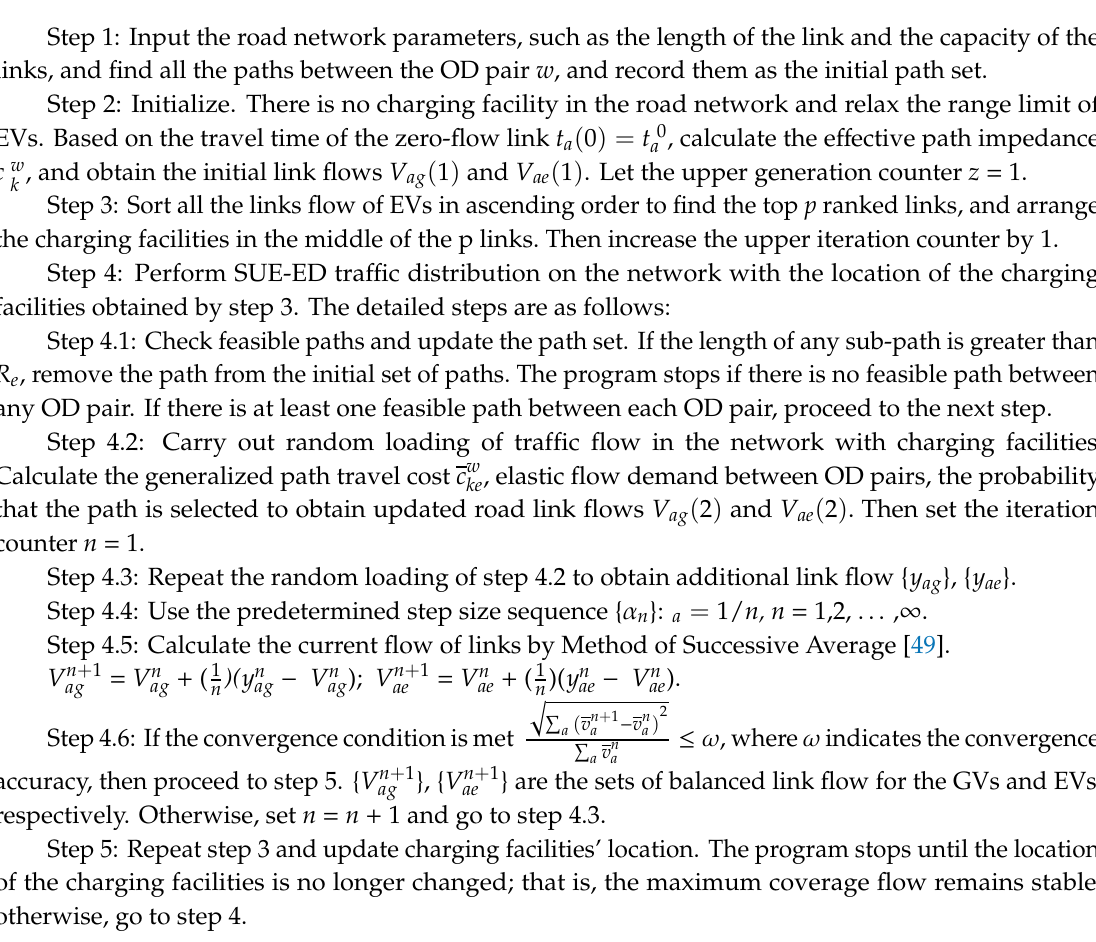
Figure 2. Framework of the bilevel model to solve the optimal location of charging stations (CSs).